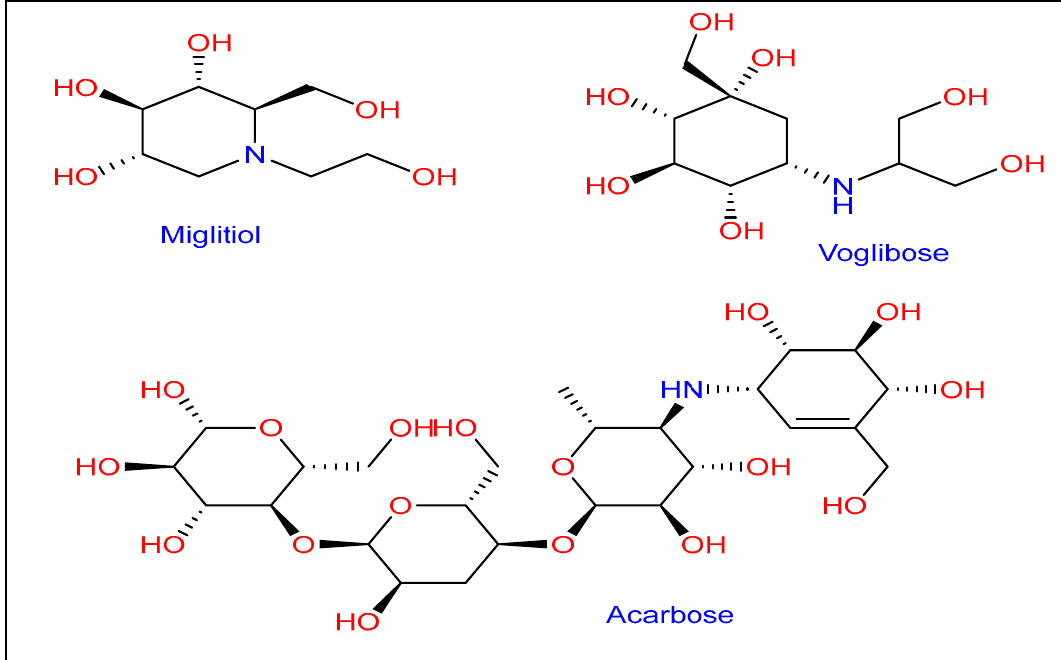
Figure 1 . Type 2 diabetes mellitus drug on the market (T2DM). Figure 1. Type 2 diabetes mellitus drug on the market